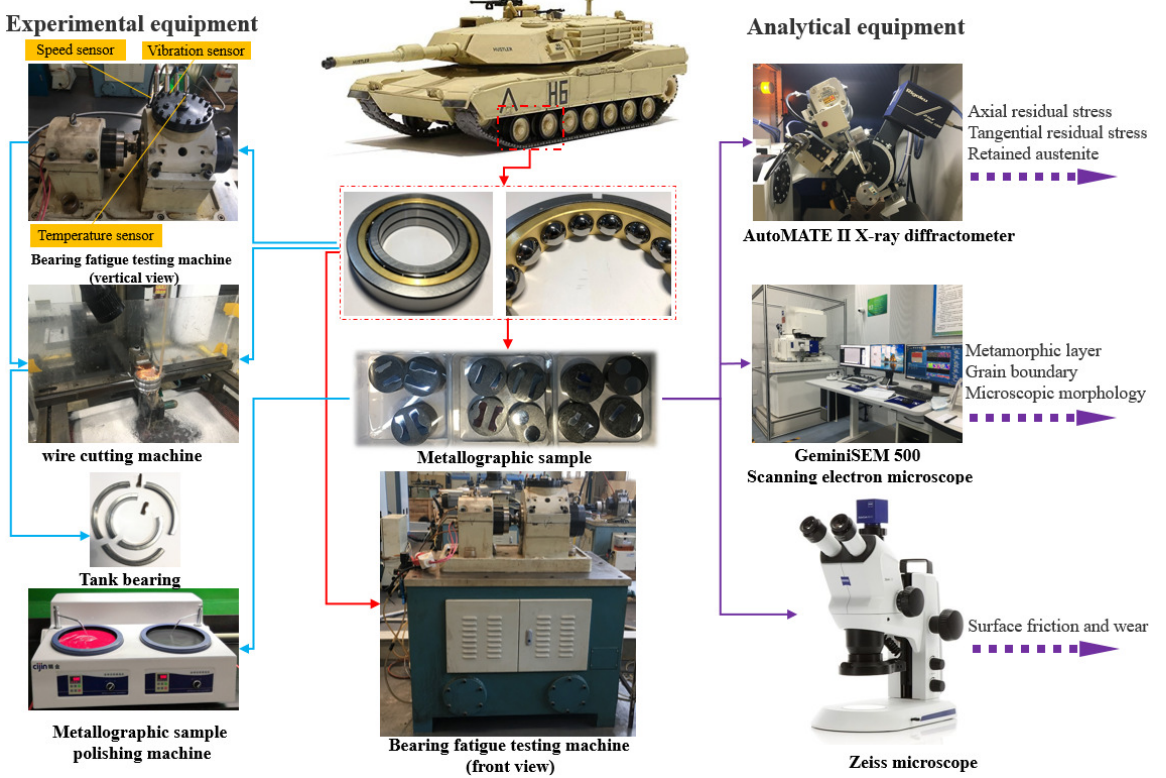
Figure 2. Experimental equipment and sequence of multidimensional analysis of high-performance bearings.